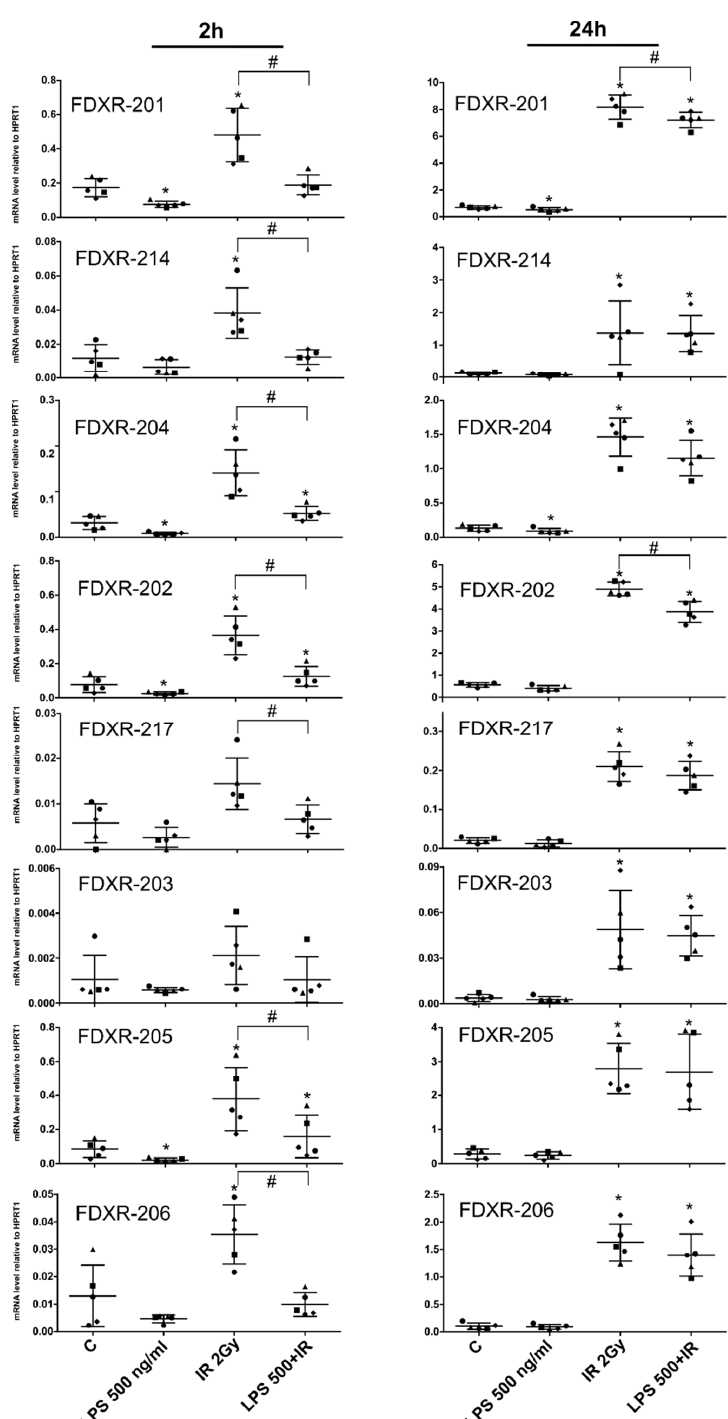
Figure 3. Gene expression profile of FDXR variants in human blood irradiated and/or stimulated with LPS ex vivo. Blood from five male donors was incubated with LPS (500 ng/mL) 1 h before irradiation (2 Gy, 0.5 Gy/min). FDXR variants expression profile was analysed 2 h and 24 h post-irradiation. Data are shown as mean ± SD ( n = 5). Statistical analyses were performed in log-transformed data. Significant differences (paired t -test, p ≤ 0.05) with the control were indicated with an asterisk (*) and differences with IR with a hash (#) (only for IR groups).